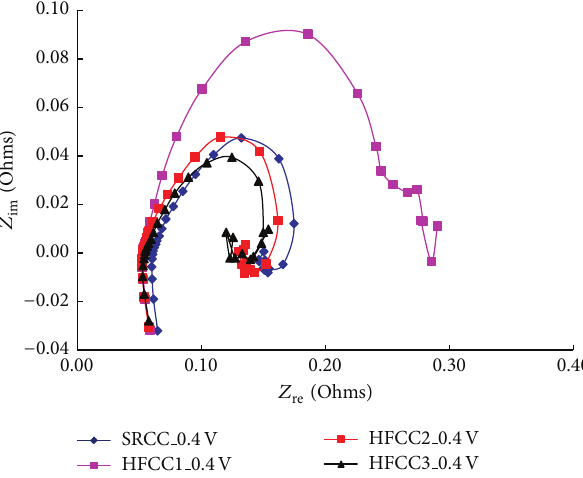
Figure 7: Comparison of the Nyquist plots at 0.4 V for the DMFC with different current